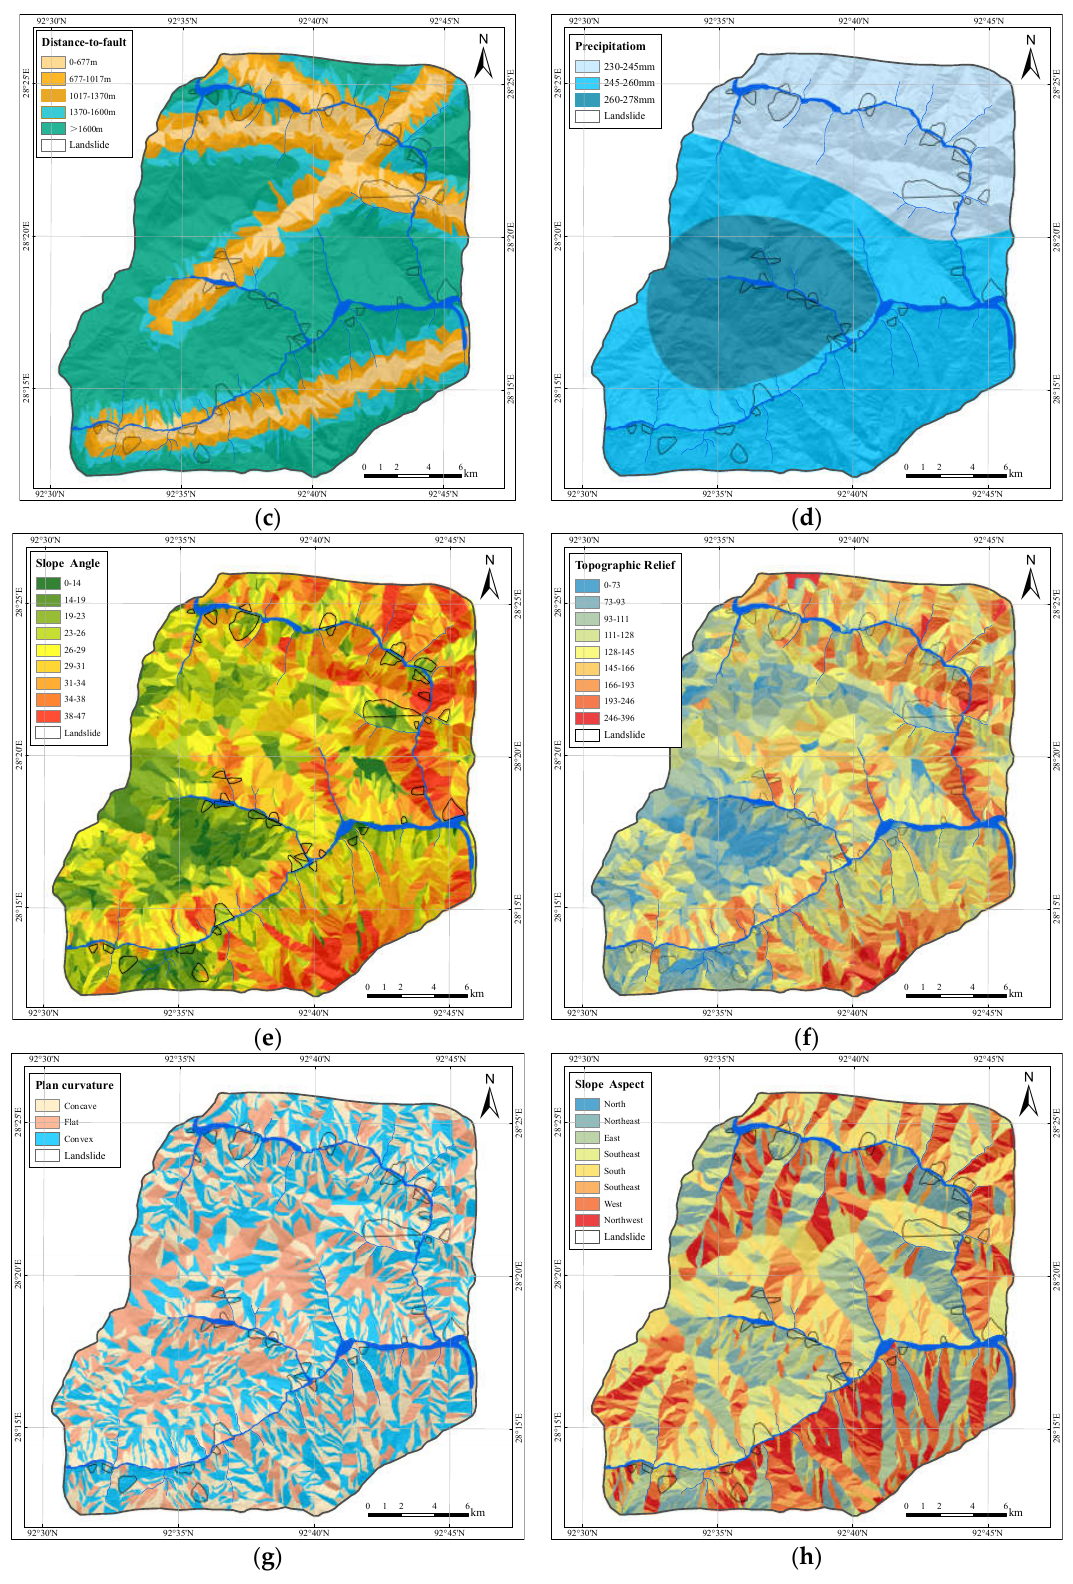
Figure 7. Maps of the influencing factors within the study area: ( a ) lithology; ( b ) distance-to-river; ( c ) distance-to-fault; ( d ) precipitation; ( e ) slope angle; ( f ) topographic relief; ( g ) plan curvature; ( h ) slope aspect.